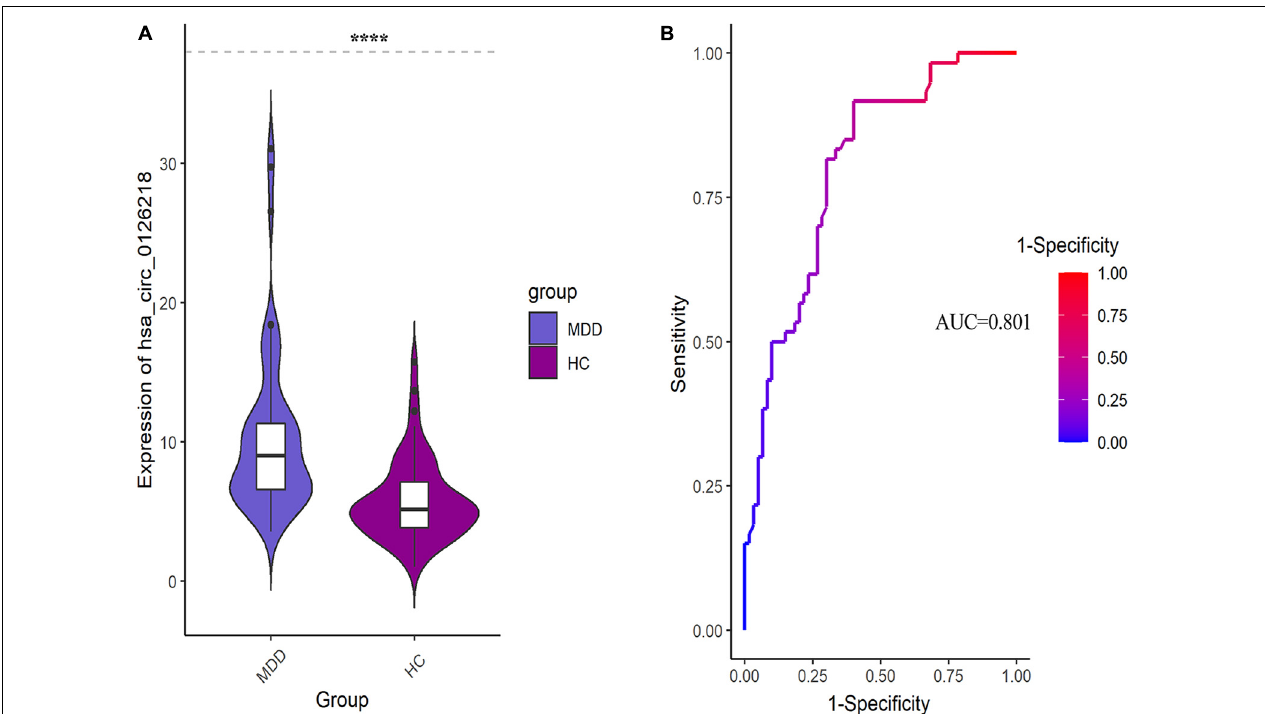
FIGURE 2 | (A) The differential expression levels and ROC curves of hsa_circ_0126218 in PBMCs between MDD patients (MDD, n = 60) and healthy controls (HC, n = 60). (B) ROC curve analysis of hsa_circ_0126218. ROC, receiver operating characteristic.